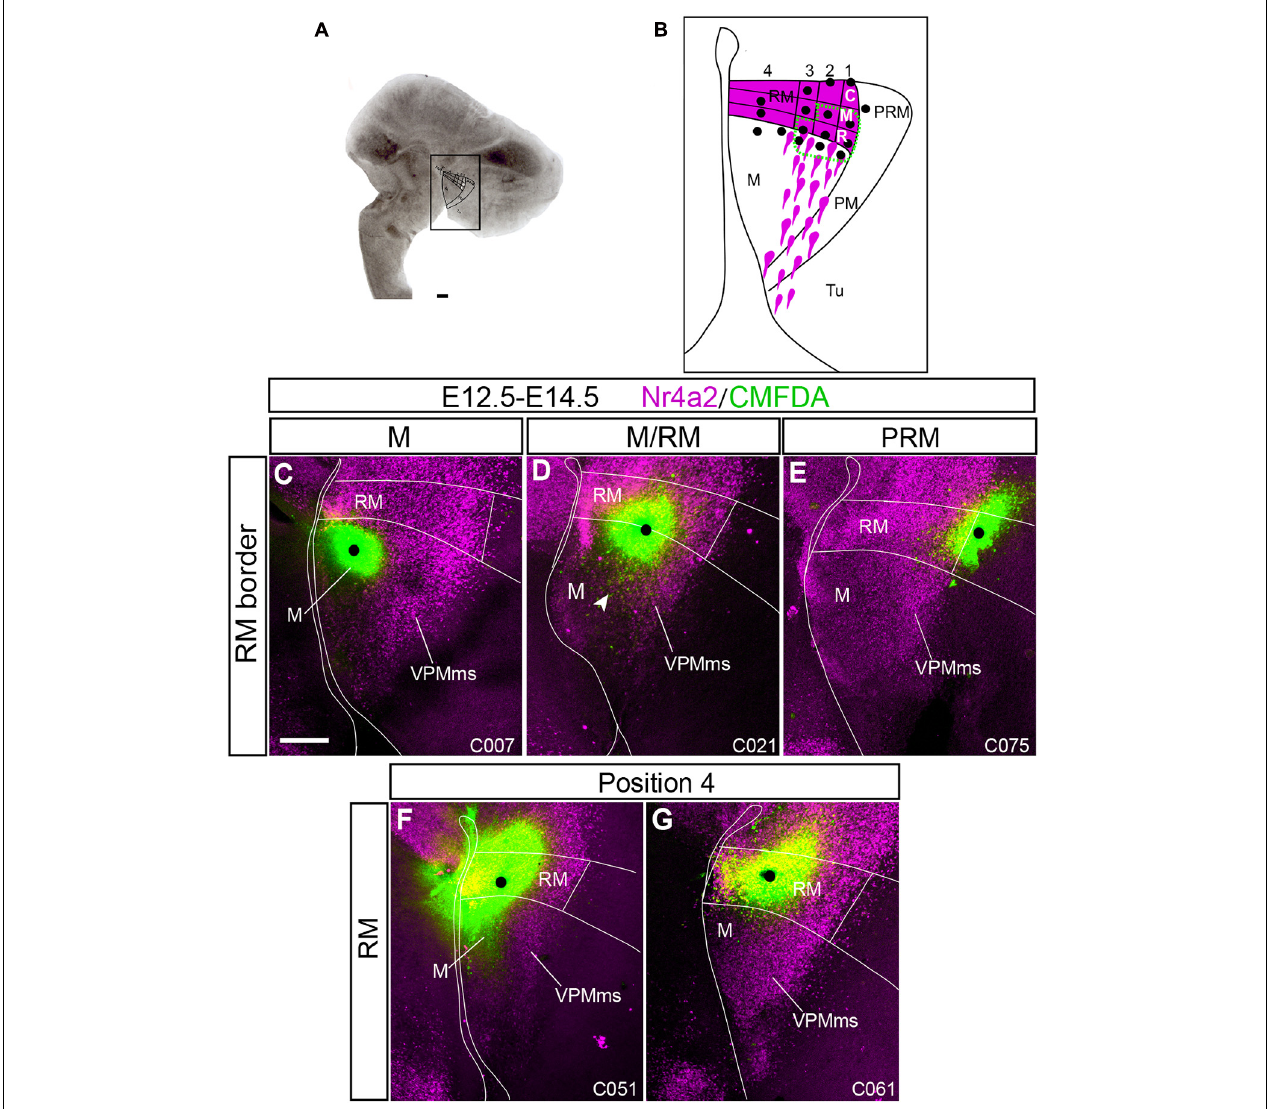
FIGURE 7 | Control experiments showing no VPMms. To narrow the optimal labeling area for VPMms within RM we marked several points inside and outside RM in our organotypic cultures (see section “Materials and Methods”) using an ad hoc subdivision system. CMDFA signal is in green and Nr4a2 immunofluorescence is in magenta. The alphanumeric identification of the cases appears at the lower right corner (compare Supplementary Table 3 ). (A) Example of our organotypic culture material in which RM, M, PRM, and PM areas are marked. (B) Schema of our arbitrary RM subdivision system. We divided RM (magenta) into dorsoventral halves, and the upper half in three longitudinal tiers, subdivided into three rostro-caudal sectors (rostral, middle, caudal). Black dots represent the marking sites of experimental cases, some of which are shown in Figures 7 , 8 . Experiments outside the area limited with a green dashed line showed no VPMms ( Figure 7 ), whereas those inside it resulted in distinct VPMms labeling (stream of green cells; Figure 8 ). (C) No migratory stream was observed when a CMFDA mark was placed strictly within the mamillary area (M; n = 5). (D) CMFDA-tungsten grains placed just in front of the M/RM boundary in an area traversed by some migrating cells showed only minor displacements toward the M area (arrowhead in D; n = 10). (E) CMFDA grains placed in PRM, even close to RM, did not elicit VPMms labeling ( n = 5). (F,G) Experiments labeling the lower half of RM (position 4 in the schema in B ) did not show marking of VPMms ( n = 3). Scale bars represent 200 µ